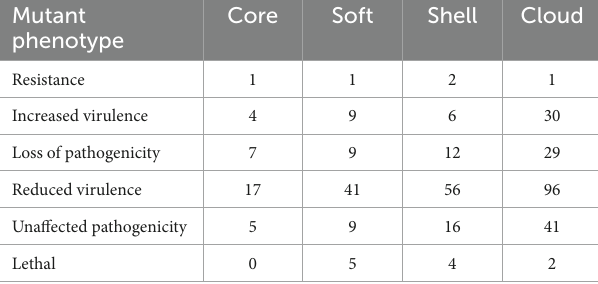
TABLE 5 PHI annotation of the core genome and the accessory genome. Mutant